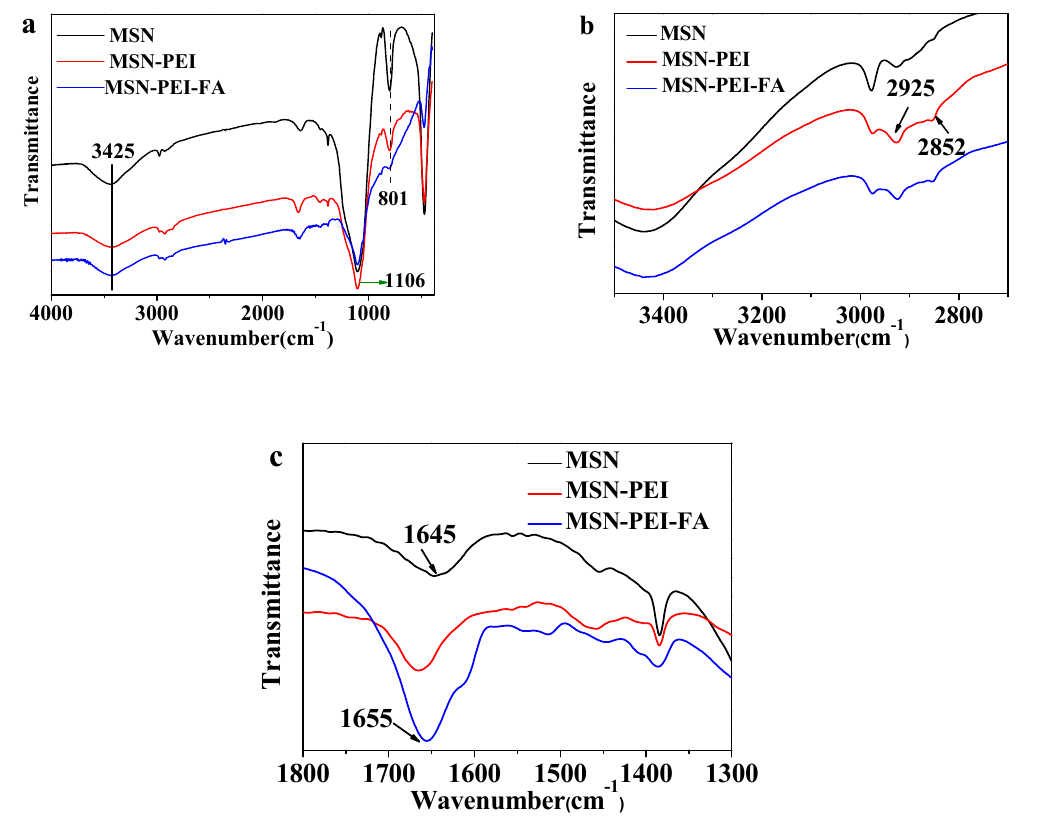
Figure 3. ( a ) The full FTIR spectra of MSN, MSN-PEI, and MSN-PEI-FA; ( b ) the FTIR spectra of MSN, MSN-PEI, and MSN-PEI-FA at 3400 cm − 1 to 2800 cm − 1 ; ( c ) the FTIR spectra of MSN, MSN-PEI, and MSN-PEI-FA at 1800 cm − 1 to 1300 cm − 1 .